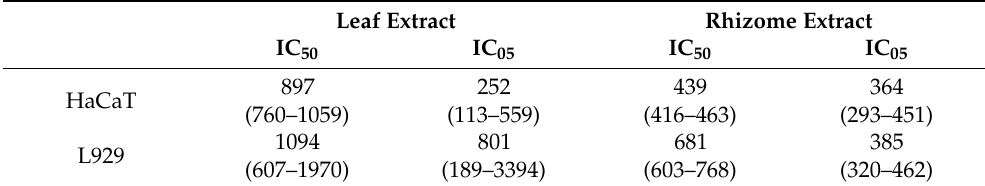
Data are expressed as extract concentrations in µg/mL. Values of 95% confidence intervals are shown in parentheses.